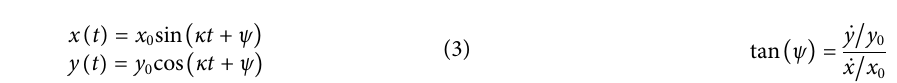
FIGURE9| Breakingofthespiralpatterninthedistribution ofopen clustersduetothedifferencebetweentheorbitalmotionoftheclustersandthepattern velocity of the rotating spiral arm. Velocity dispersion is introduced in the non-rotating frame of reference and describes the epicyclic motion. If the difference between the orbital velocityandthepatternvelocitywaszero,theclusterwouldnotdeviate(inthissimpleapproximation)farfromthespiralarm,itwouldratheroscillatearoundapointwithin the arm. The pattern breaking is dominated by the rotation curve — most of the clusters in the Local Arm are located beyond the corotation radius of this model, which results in the clusters trailing behind the spiral arm.